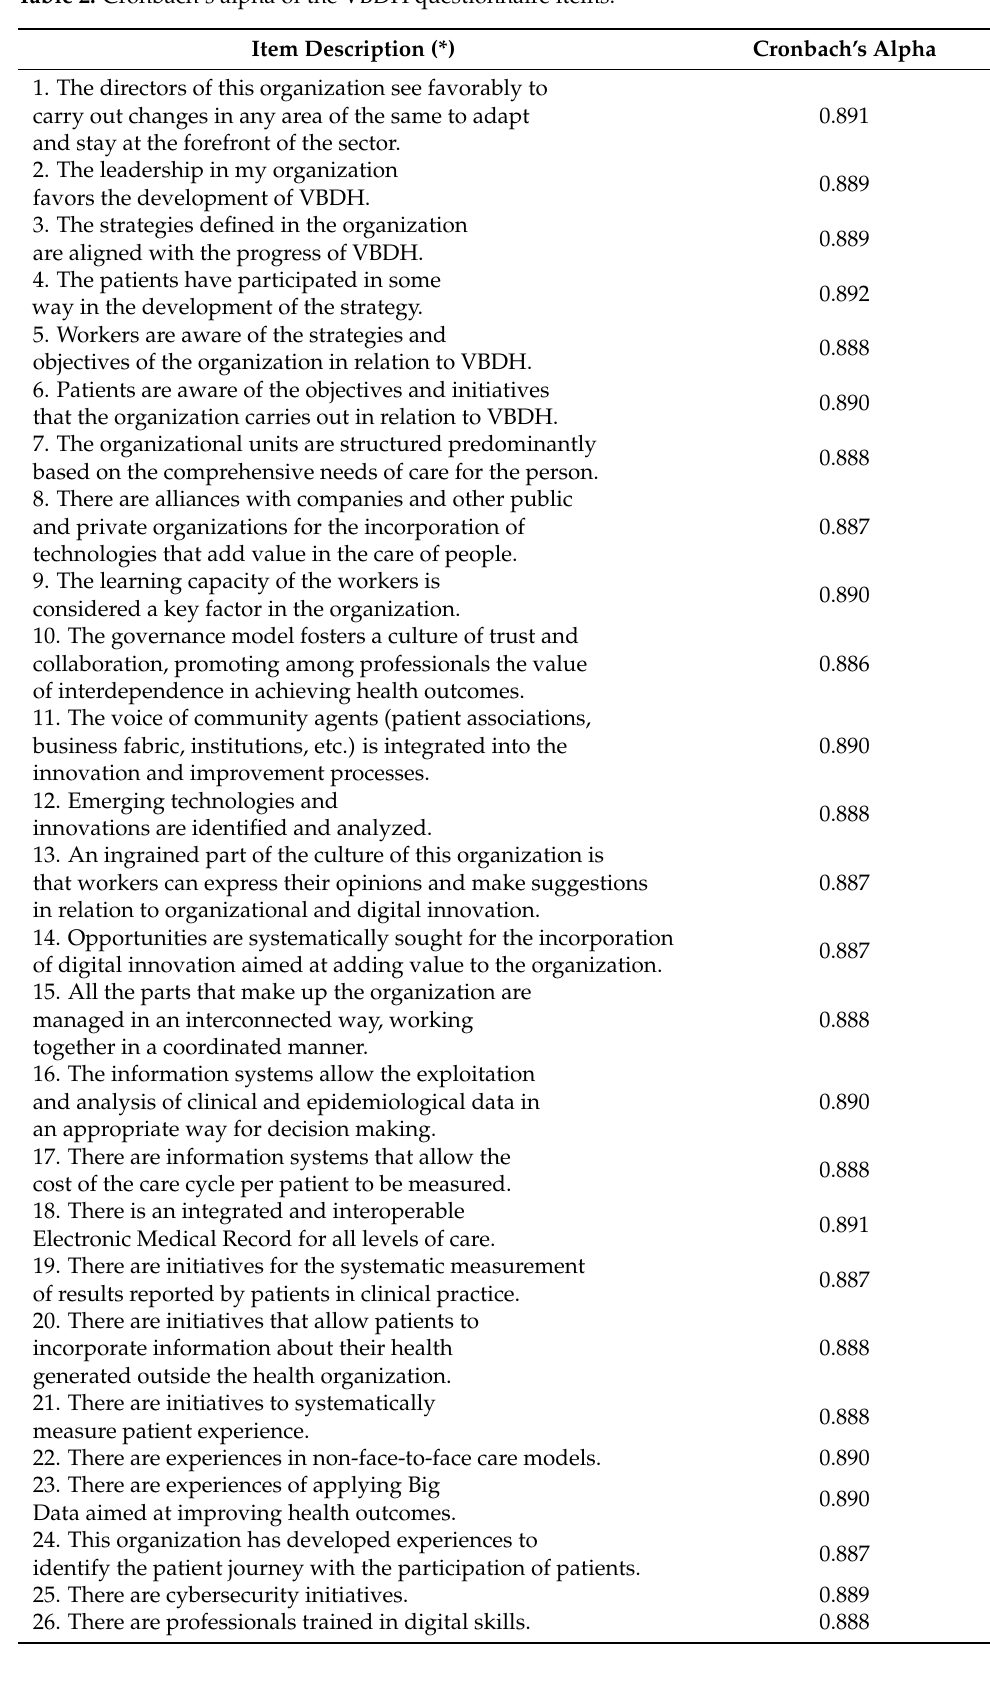
Table 2. Cronbach’s alpha of the VBDH questionnaire items. Item Description